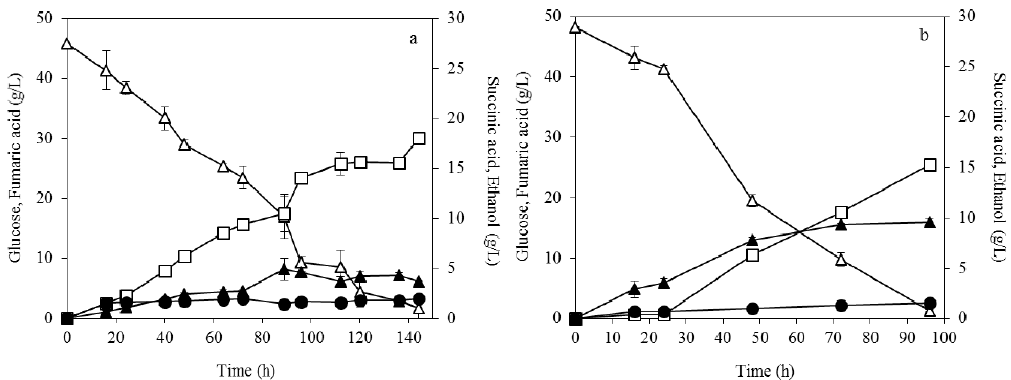
Figure 5. Effect of dispersed mycelia morphology on fumaric acid ( □ ), ethanol ( ▲ ) and succinic acid ( ● ) production during submerged fermentation of R. arrhizus NRRL 2582 at 45 g/L initial glucose concentration ( △ ). The initial ammonium sulphate concentration was ( a ) 0.04 g/L and ( b ) 0.2 g/L.